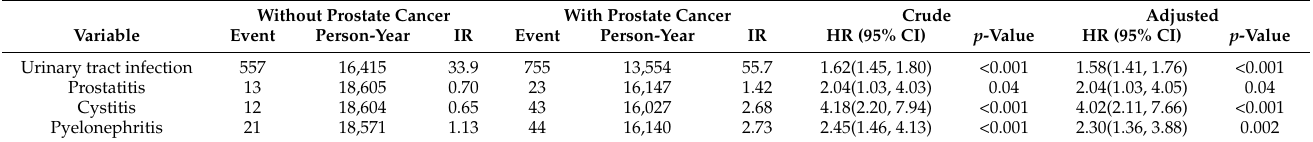
Table 3. Comparisons of the incidence of urinary tract infections, prostatitis, cystitis, and pyelonephri- tis between the patients with and without prostate